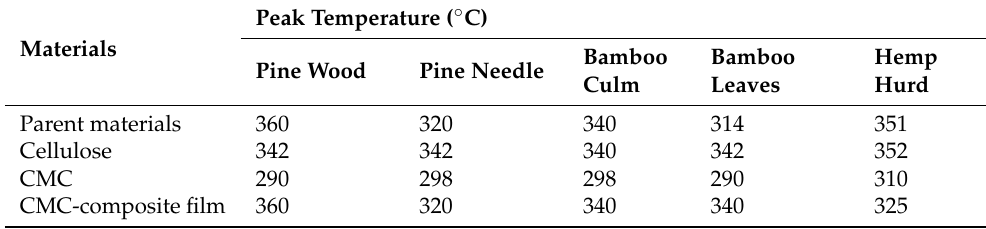
Table 4. Temperature at which the second peak was observed during